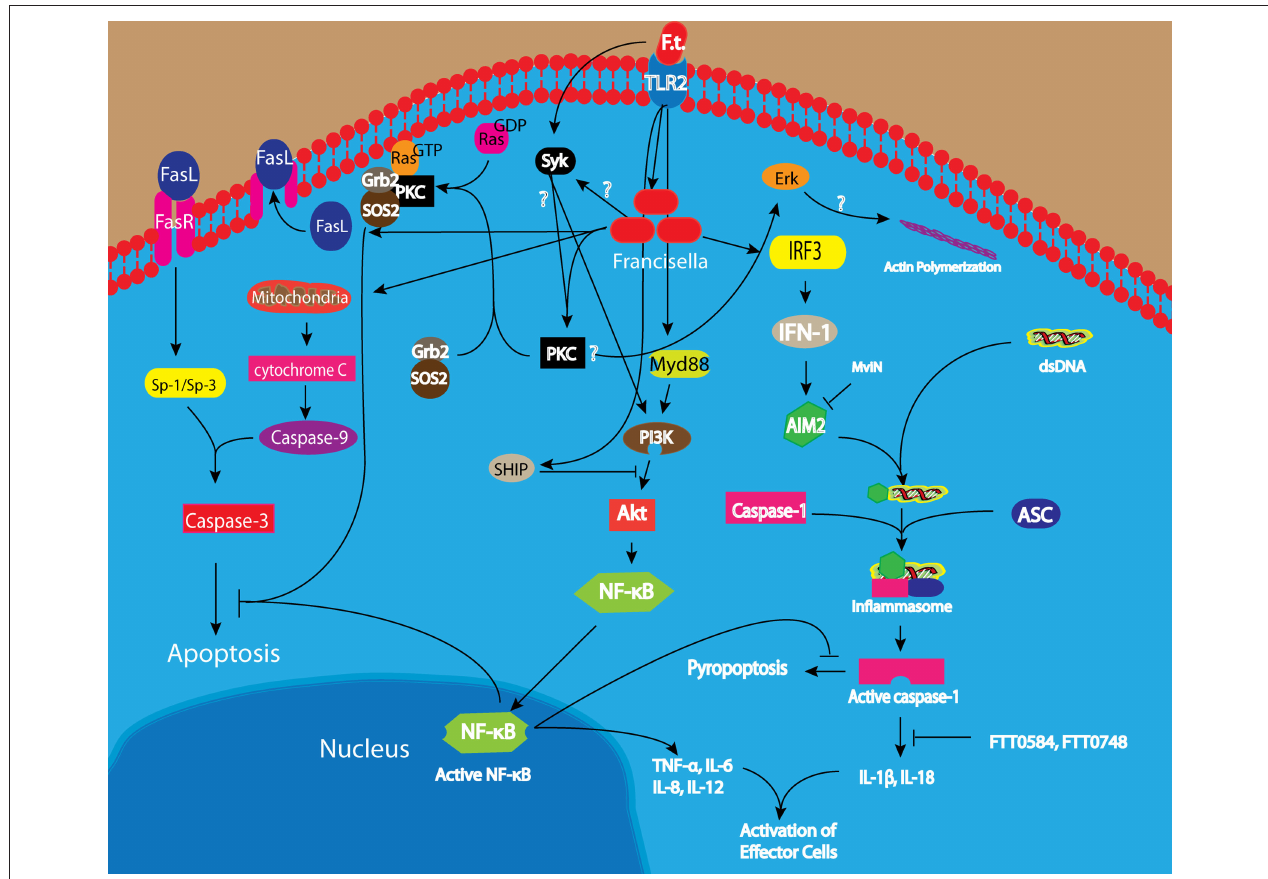
FIguRe 2 | entry into and evasion of host cell innate immune response by Francisella tularensis . Phagocytosis of F. tularensis by macrophages is mediated by Syk-dependent activation of Erk, which likely triggers actin polymerization at the phagocytic cup. In addition, there is TLR2 dependent activation of Akt leading to induction of proinflammatory cytokines and phagosomal maturation. Akt activation